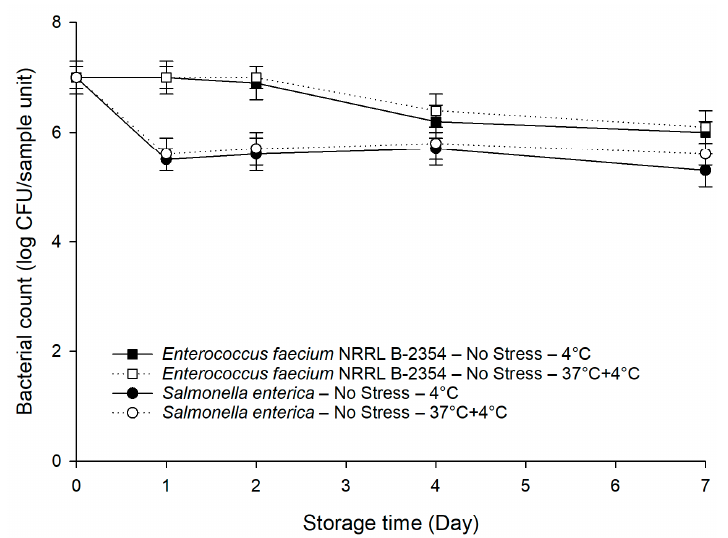
Figure 3. Persistence of E. faecium NRRL B-2354 on baby spinach under cold and temperature abuse conditions without prior exposure to sub-lethal stresses compared to a mixture of three S. enterica serovars. Error bars represent standard deviations (n = 3).